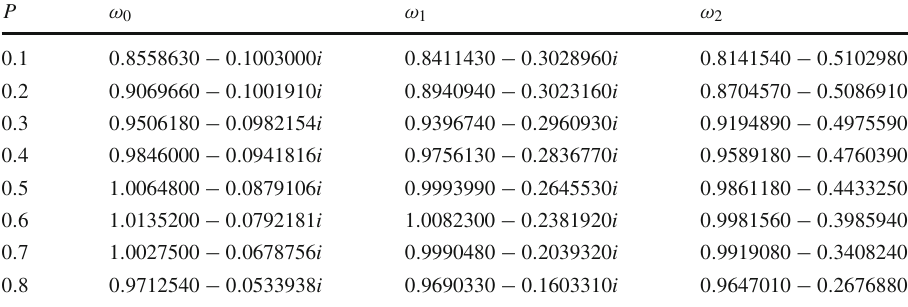
Table 3 The first LQBH’s quasinormal modes for l = 4